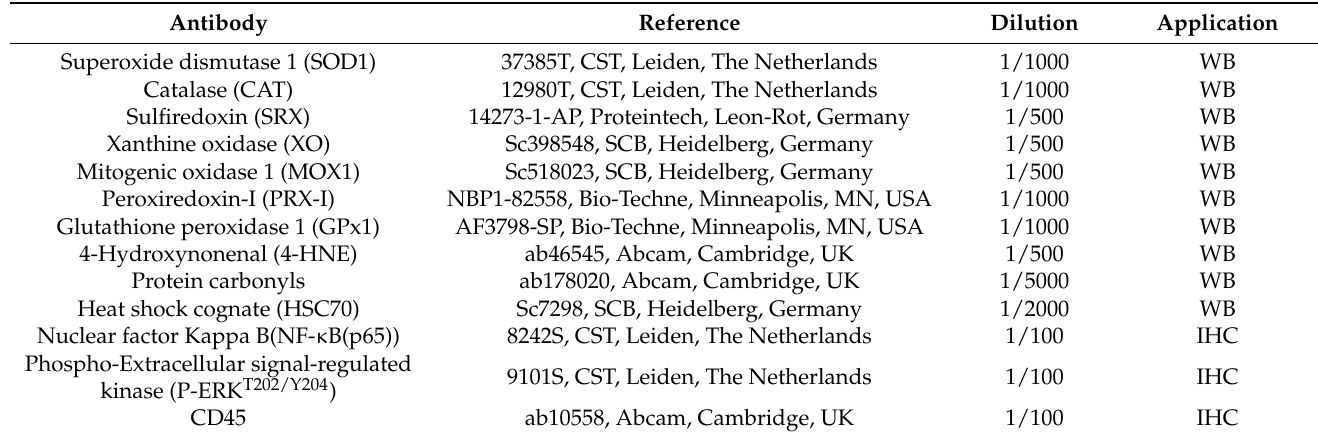
Table 1. Antibodies used in western blot (WB) and immunohistochemistry (IHC) experiments. CST, cell signaling technology; SCB, Santa-Cruz